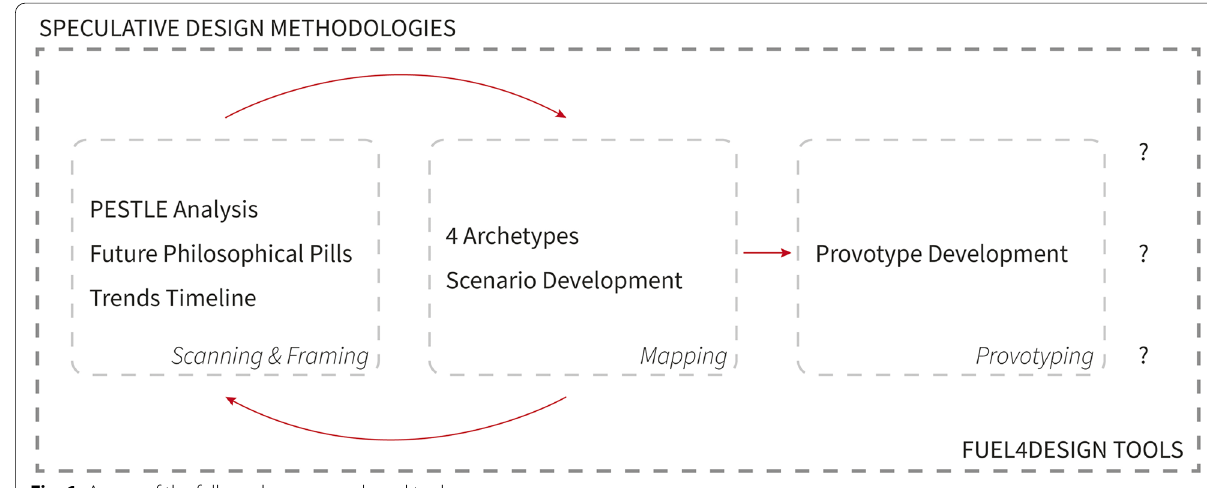
Fig. 1 A map of the followed process and used